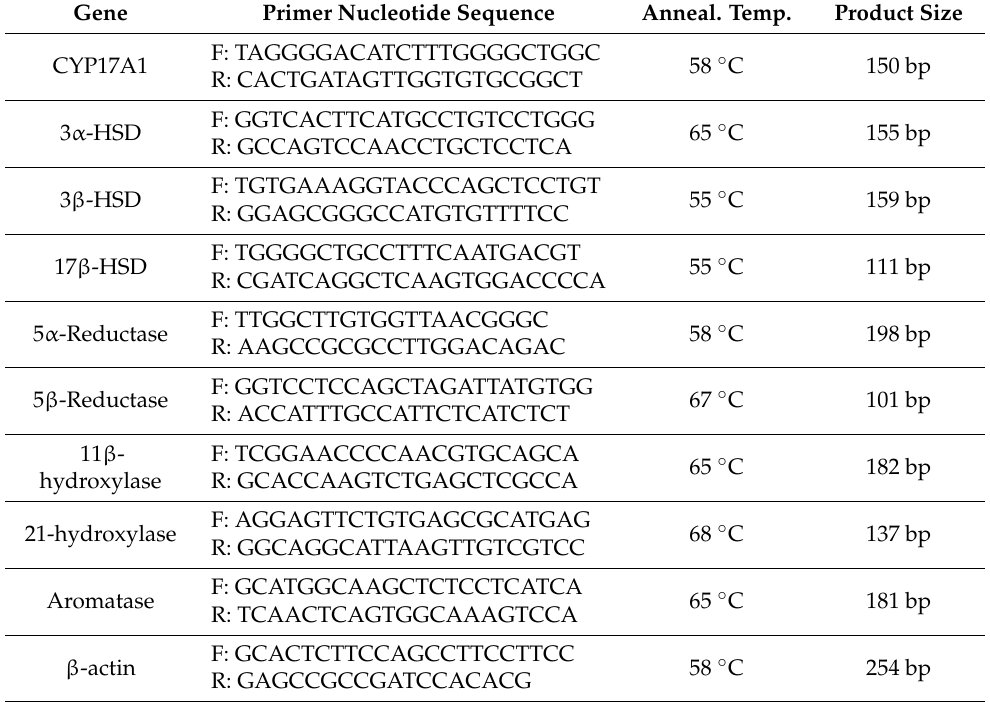
Table 1. List of primers used for